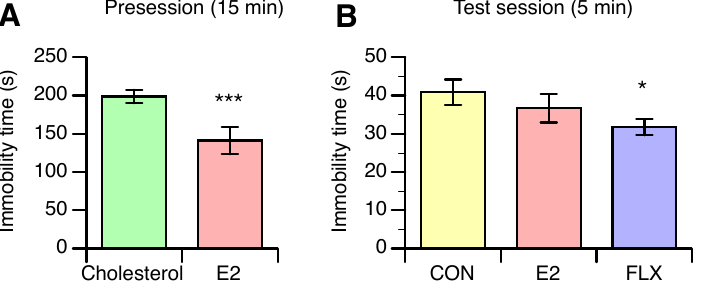
Figure 4. The e ff ect of estradiol replacement in ovariectomized female rats on the immobility time in the presession of Porsolt’s forced swim test (FST) before the fluoxetine treatment ( A ), and e ff ects of estradiol or fluoxetine on the immobility time in the test session of FST ( B ). Female rats were ovariectomized and assigned to the estradiol- or cholesterol-treated group. Six or seven days after ovariectomy, half of the cholesterol-treated rats were subcutaneously ( s.c. ) injected twice daily with 5 mg / kg fluoxetine (FLX) at ZT0 and ZT12, while the other half of the cholesterol-treated rats (CON) and all of the E2-treated rats (E2) were s.c. injected with the same volume of saline. The presession was performed before FLX treatment, and the test session was conducted on the seventh day after the onset of daily FLX treatment. Data are shown as the mean ± SEM ( n = 13 in CON; n = 14 in E2; n = 13 in FLX). Note: * and ***: significant di ff erences at p < 0.05 and p < 0.001, respectively, compared to the CON